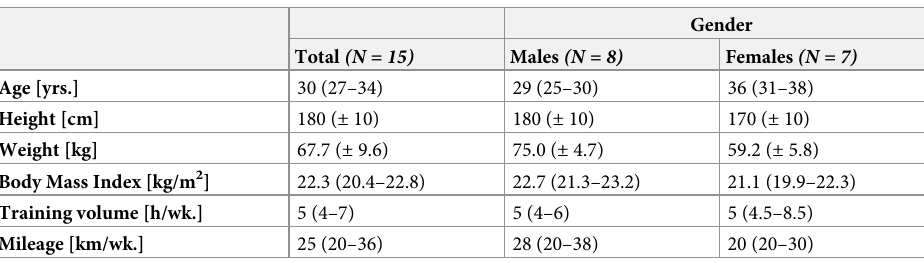
Table 1. Baseline